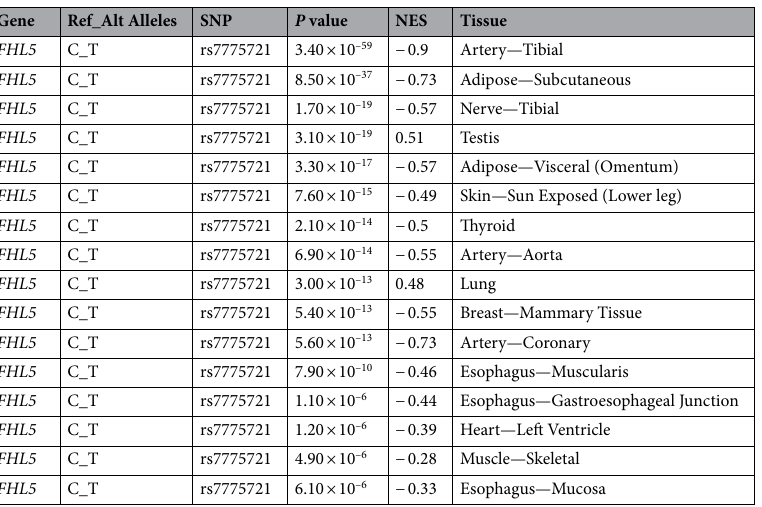
Table 3. Significant sQTL signals of SNP rs7775721 on FHL5 . Ref_Alt Alleles: reference and alternative